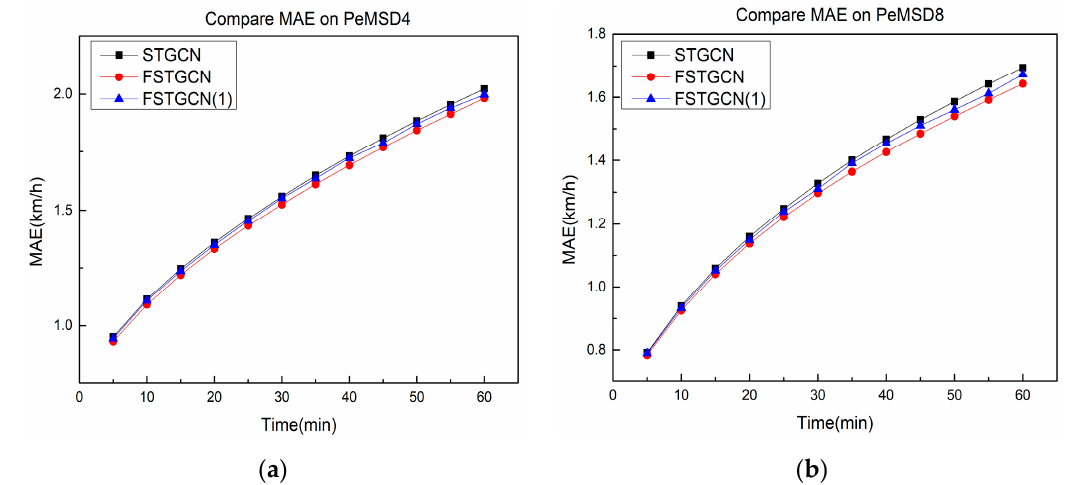
Figure 8. Evaluation of the predicted traffic flow. ( a ) PeMSD4. ( b ) PeMSD8. Except for the predicted traffic flow in module A, the dynamic adjacency matrix fusing